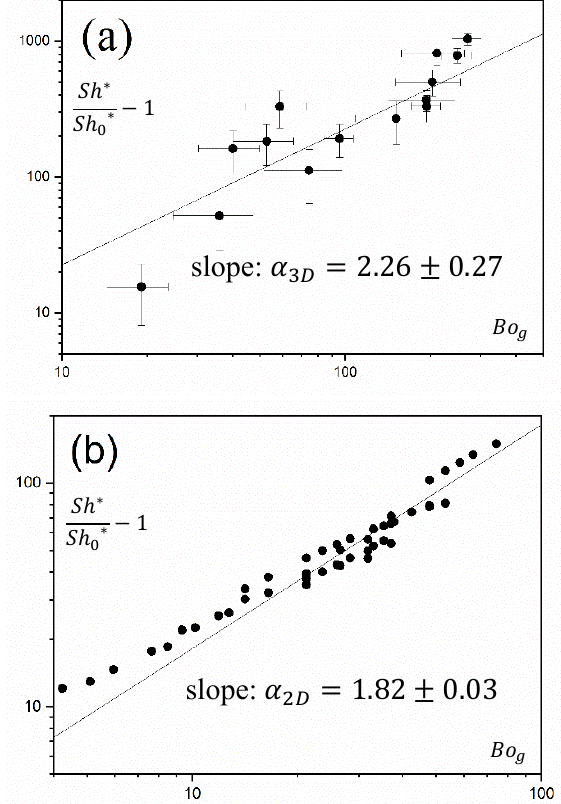
Fig. 3. Plot and linear regression (with the corresponding 𝑆ℎ ∗ − 1 versus the granular Bond number 𝐵𝑜 𝑔 values of 𝛼 ) of 𝑆ℎ 0∗ for (a) the 3D experiments [11] and (b) the 2D numerical